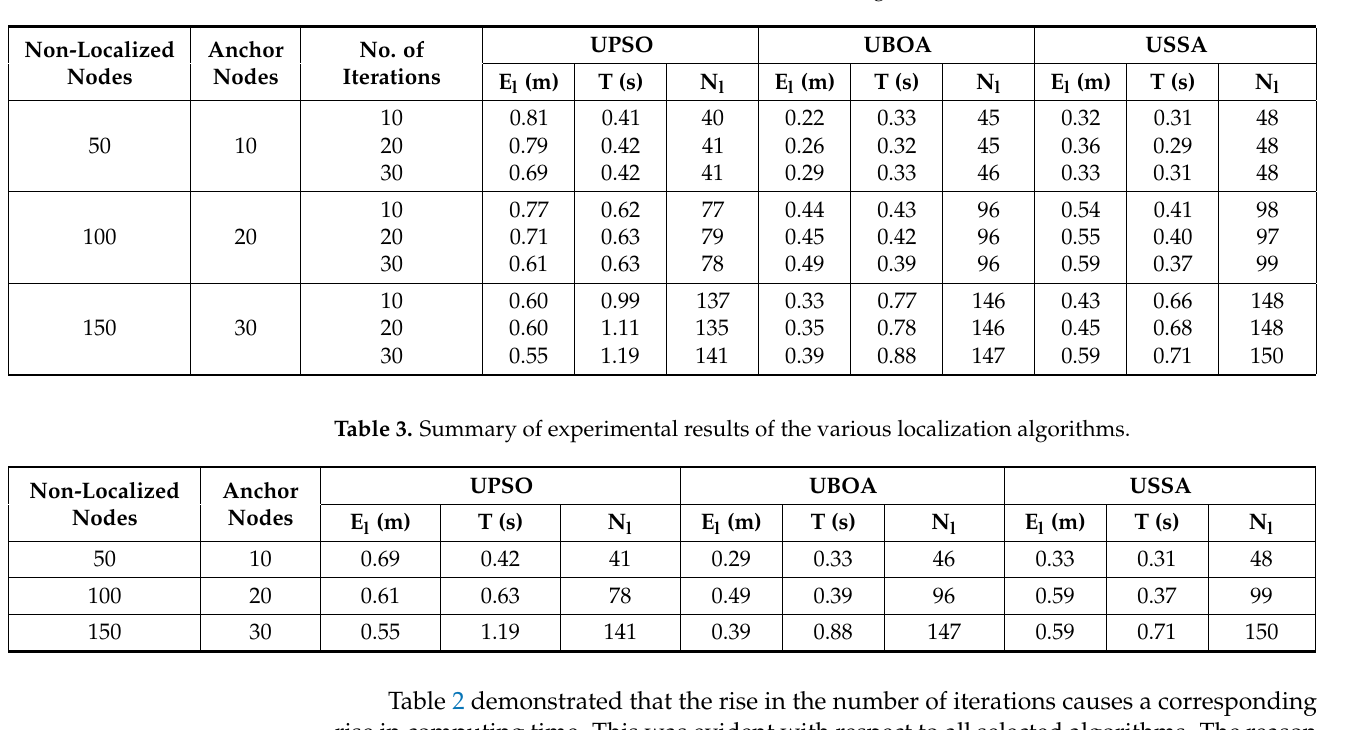
Table 2. Performance metrics of various localization algorithms.